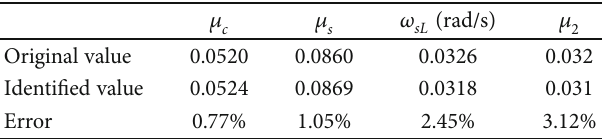
Table 2: Original values and identi fi ed values of the working load model.